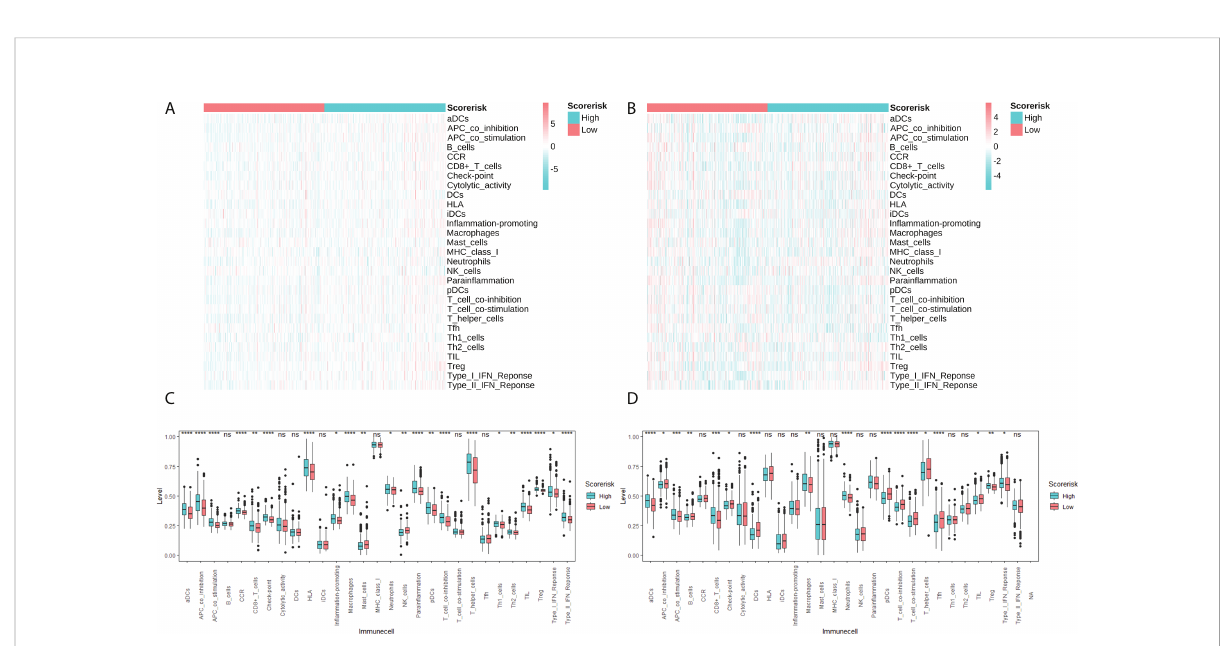
FIGURE 7 Single sample gene sets enrichment analysis (ssGSEA) of immune hallmarks. Heatmap of ssGSEA scores among low- and high-risk groups in TCGA (A) and CGGA (B) cohorts. Difference analysis of tumor-in fi ltrating immune cells, immune scores, and stromal scores in the TCGA cohort (C) and the CGGA cohort (D) . ns, not signi fi cant; * P < 0.05; ** P < 0.01; *** P < 0.001; **** P <